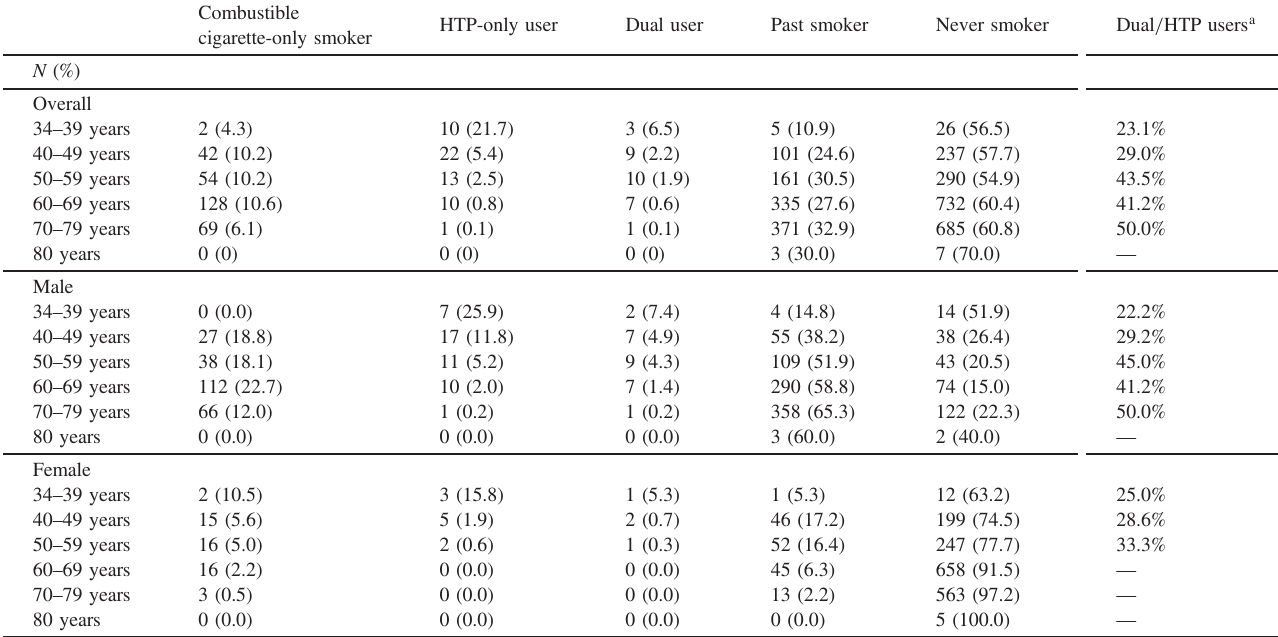
Table 3. HTP use strati fi ed by sex and age